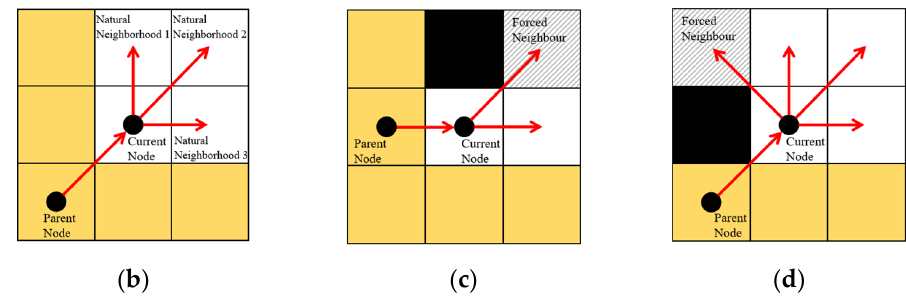
Figure 5. JPS algorithm’s neighbor-pruning rule and forced-neighbor judgment method. ( a ) Neighbor pruning in the linear extension state. ( b ) Neighbor pruning in the diagonal expansion state. ( c ) Forced neighbors in the linear extension state. ( d ) Forced neighbors in diagonally extended states. The JPS algorithm is much lower than the A* algorithm in terms of time complexity.